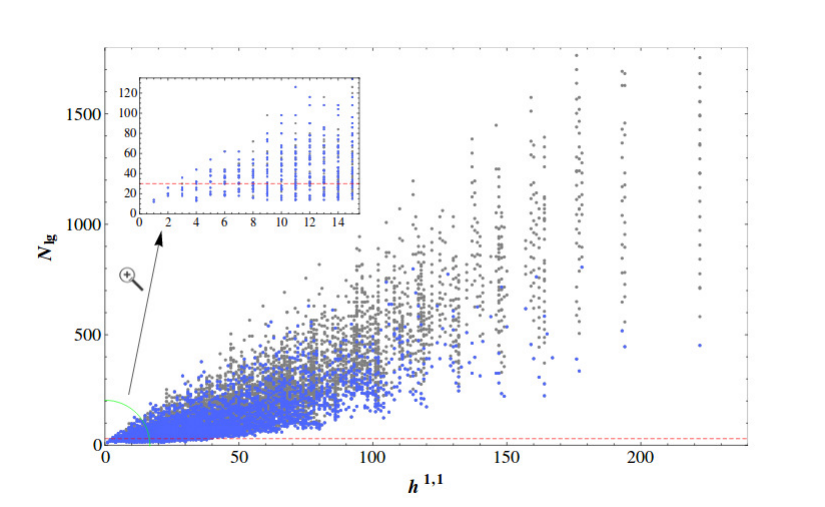
Figure 4 . For a subset of the Kreuzer-Skarke database [109], the maximal possible gauge group rank in perturbative type IIB string theory grows approximately linearly with h 1 ; 1 . This argument and the above (cid:12)gure are taken from